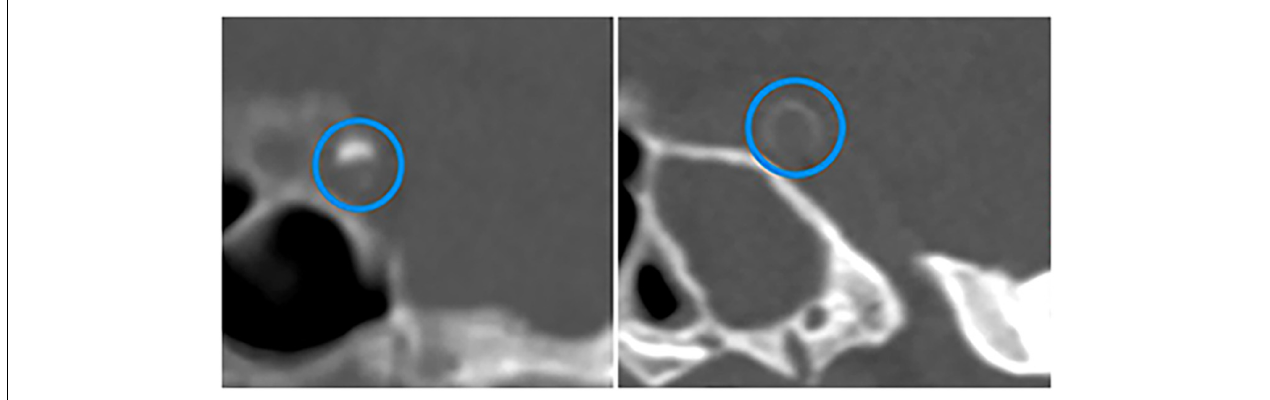
FIGURE 3 | CT images of calcifications in different layers of intracranial internal carotid arteries. Intimal calcification (the left) and medial calcification (the right) are marked by blue circles. Adapted from Kockelkoren et al. (2017).